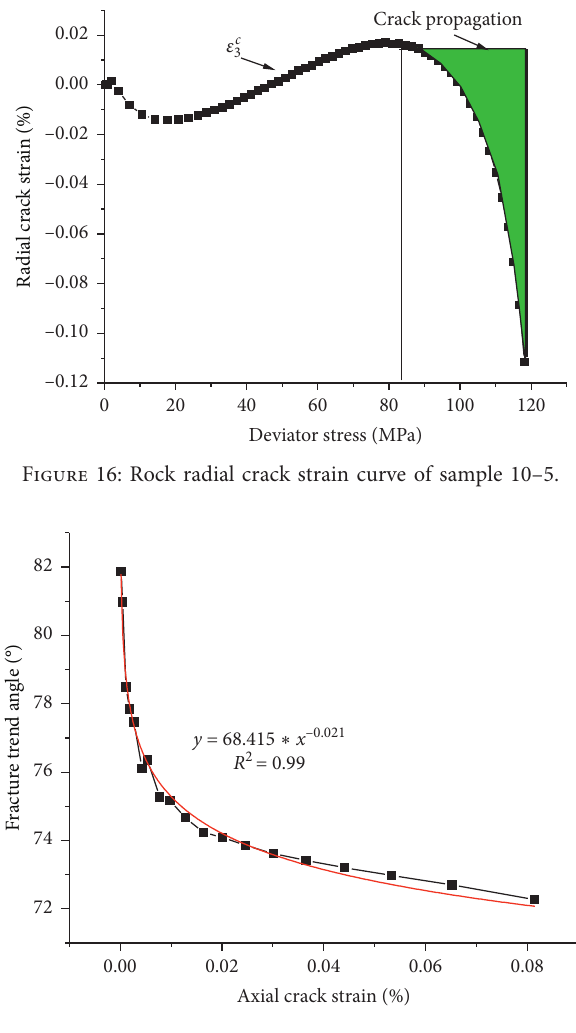
Figure 17: Radial crack strain curve of sample